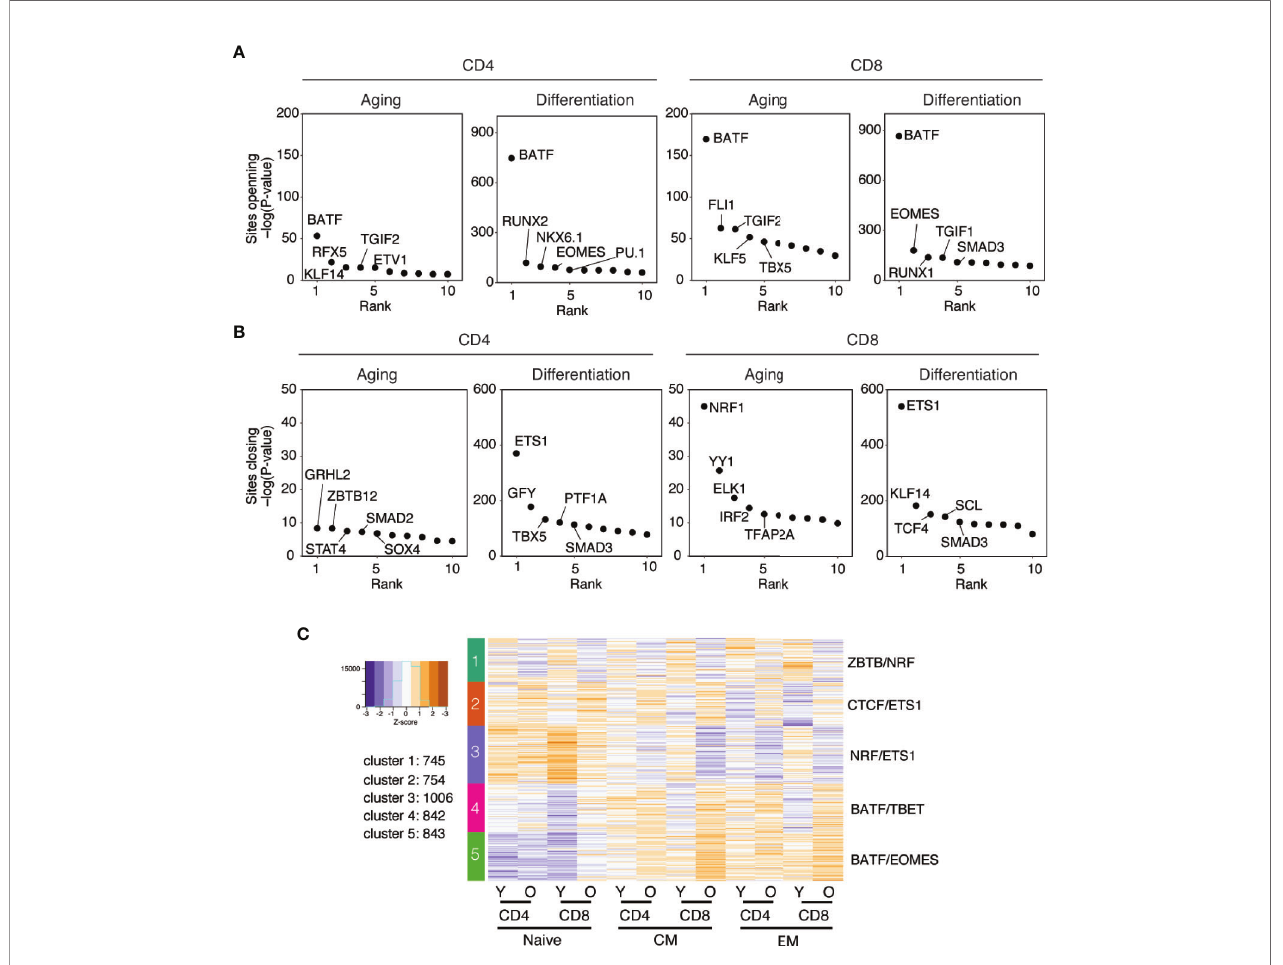
FIGURE 3 | Transcription factor networks in T cell aging and differentiation. (A, B) TF motif enrichments at sites more (3A) or less accessible (3B) with age and differentiation in CD4 (left) and CD8 (right) T cells are compared. X-axis shows the rank of the TFs, y-axis the signi fi cance level of TF motif enrichment (C) k -means analysis of sites differentially accessible with age as de fi ned in Figures 2A, B . The number of clusters was determined by gap statistics, and results are shown as heat plots with each horizontal line representing a differentially open site (left). Columns represent CD4 and CD8 T cell subsets and colors z -scores of openness. Top transcription factor motifs signi fi cantly enriched at the sites within each cluster are indicated at the right